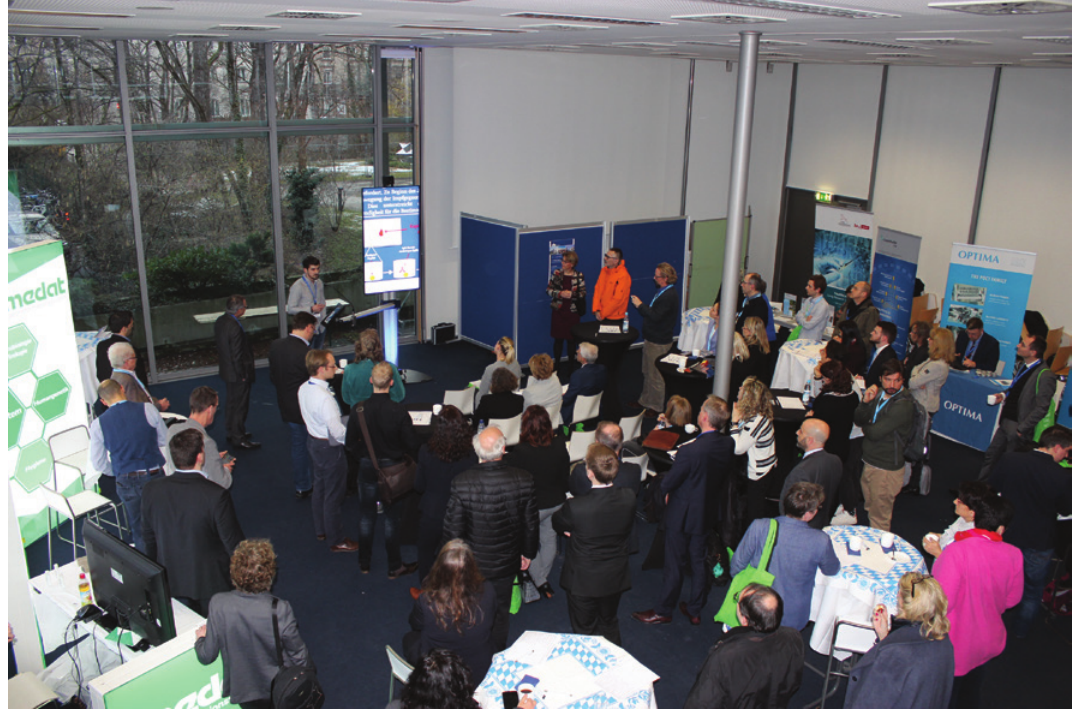
Figure 3: ePoster session, frontal presentation by an